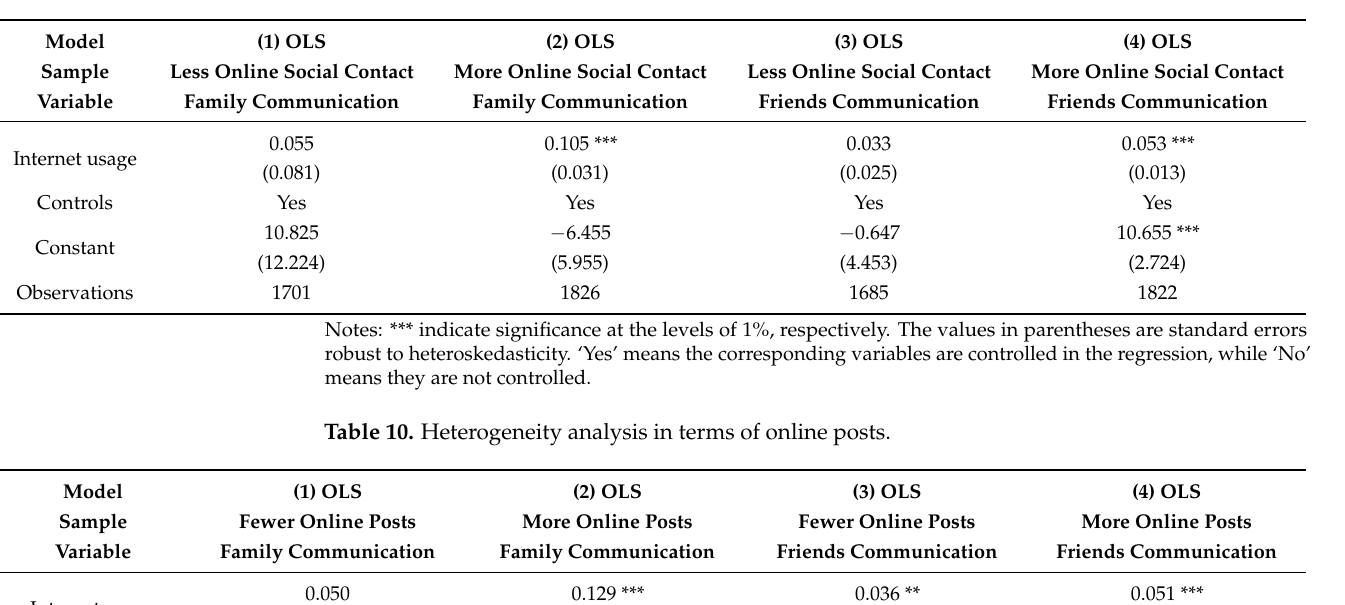
Table 9. Heterogeneity analysis, in terms of online contacts.